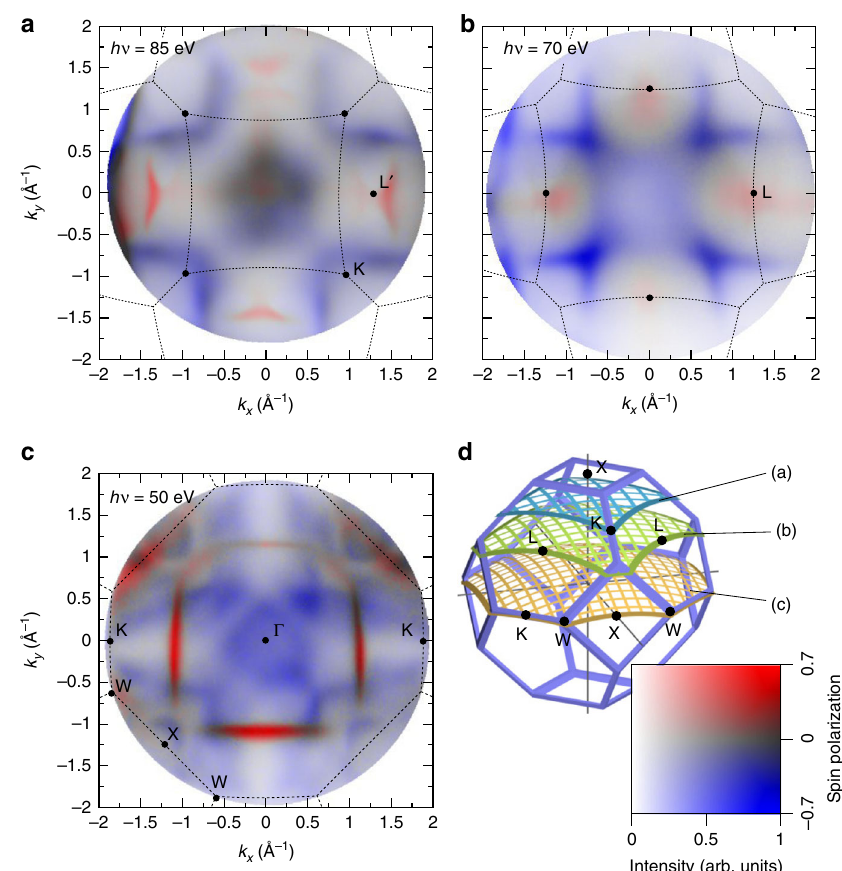
Fig. 1 Measured spin-resolved Fermi surface of fcc cobalt. Spin-resolved photoemission intensities in selected sections through the three-dimensional Fermi surface of 18 ML Co/Cu(100) measured at photon energies of hv = 85 eV ( a ), hv = 70 eV ( b ), and hv = 50 eV ( c ). The boundary of the bulk fcc Brillouin zone is indicated in each section together with the high-symmetry points. Electronic features are repeated in neighbouring zones, as indicated for the points L ′ and L that both belong to the “ neck ” -like connection of the majority FS at the (111) faces. d The fcc Brillouin zone together with the corresponding cuts sampled by a – c . According to the 2D colour code at the lower right, red and blue intensities correspond to majority and